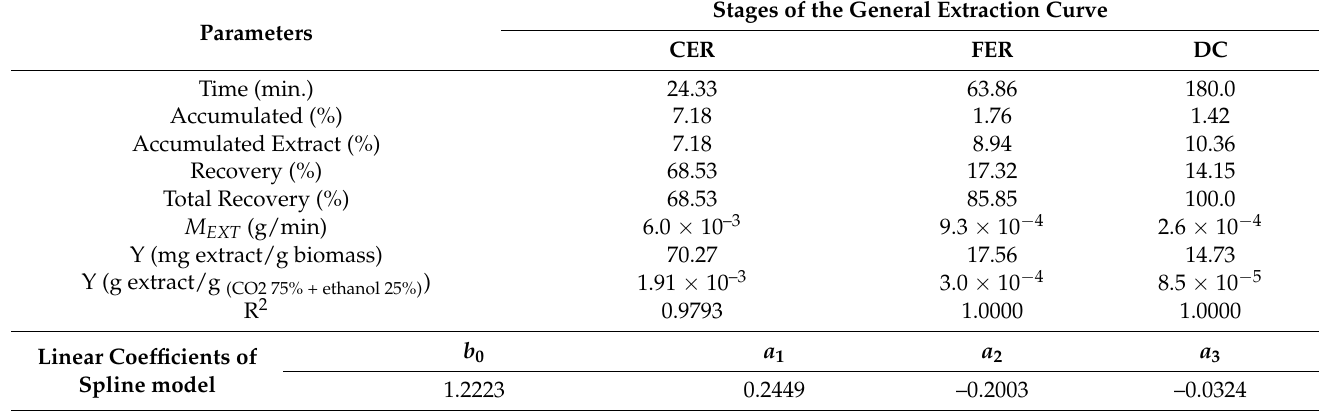
Table 1. Adjusted parameters of the spline linear model to supercritical fluid extraction (SFE) from Coccomyxa onubensis biomass at P = 40 MPa, T = 50 ◦ C, and CO 2 + ethanol (75:25 v / v ) flow rate. Stages of the General Extraction